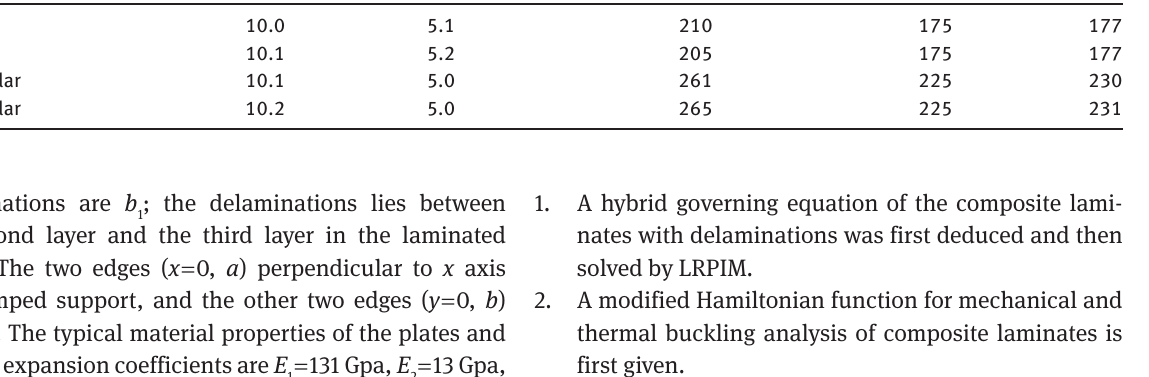
( ° C) of symmetric angle-ply (0/ ± 45/0 cr